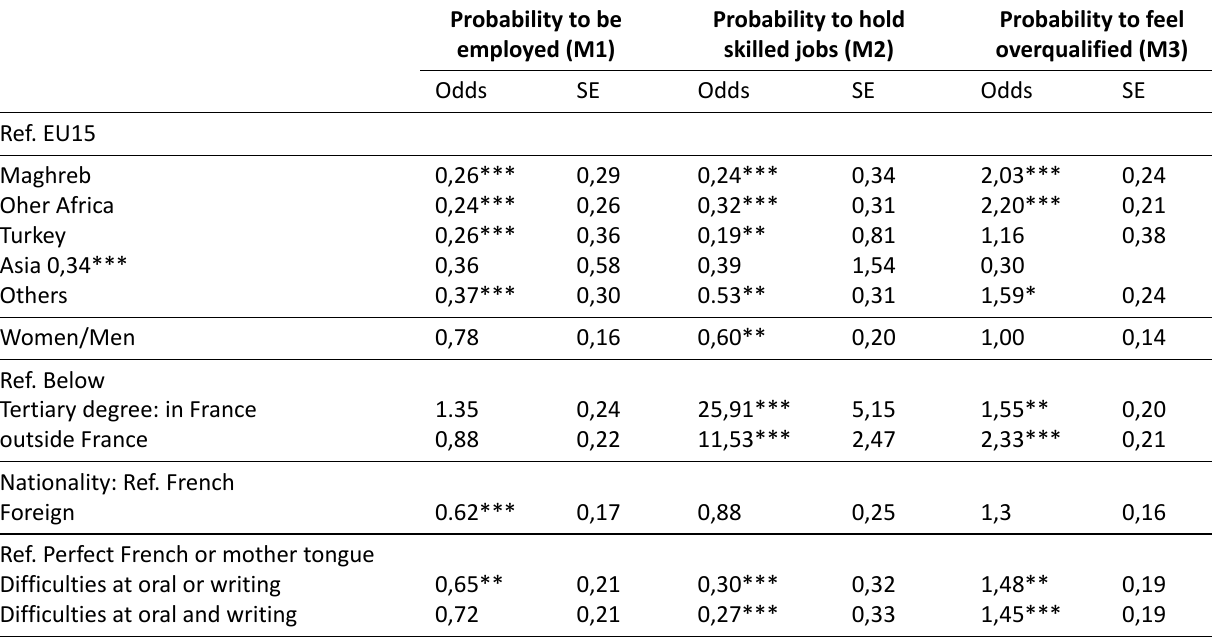
Table 3. Logistic regressions on labour market outcomes among immigrants (odds ratios). Source: INSEE Labour Force Survey 2014 § adhoc module.